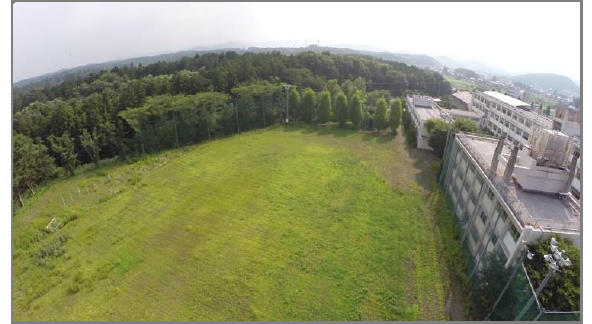
Figure 3. Test field